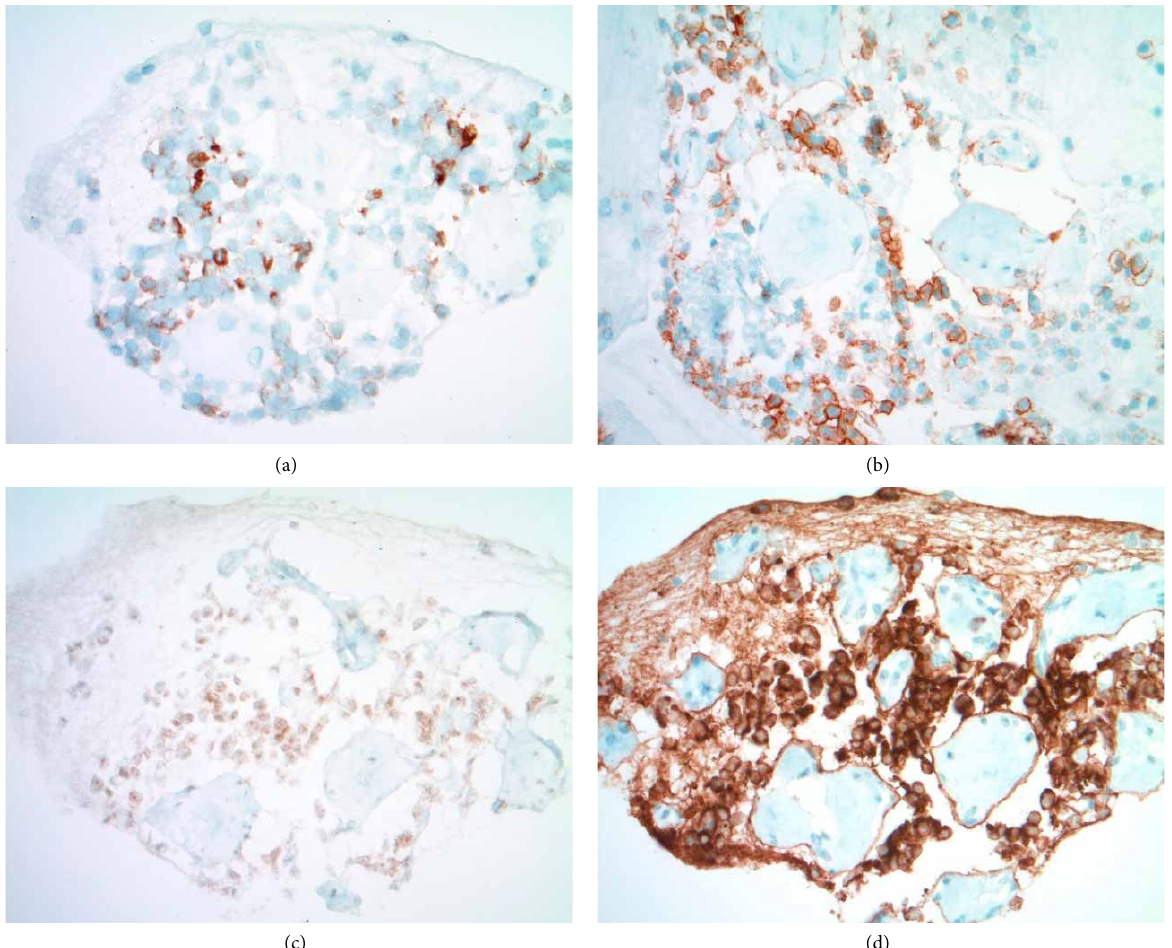
Figure 8: (a) Cell block showing cytoplasmic immunoreactivity for scattered small to intermediate sized, high nuclear/cytoplasmic ratio cells present between spheroids (CK AE1-3 immunohistochemistry, 400X). (b) Cell block with similar pattern of immunoreactivity ( β -catenin immunohistochemistry, 400X). (c) Cell block with patchy/weak cytoplasmic immunoreactivity (Chromogranin A immunohistochemistry, 400X). (d) Cell Block with diffuse and strong immunoreactivity in epithelioid cells, while spheroids and intrinsic spindled nuclei appear nonreactive (Synaptophysin immunohistochemistry,